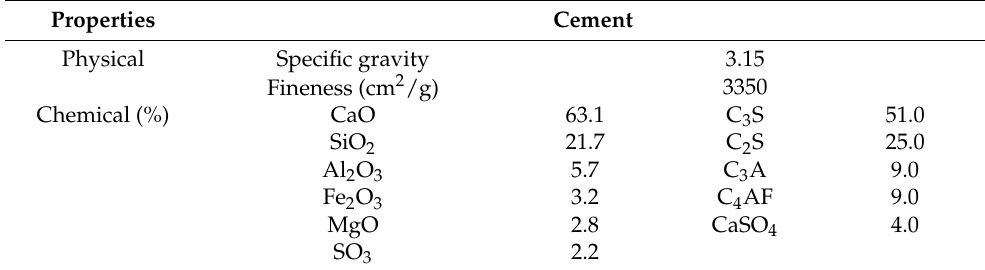
Table 4. Physical and chemical composition of the cement.